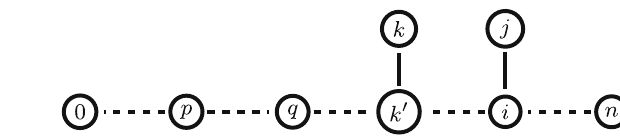
Figure 22: Minimum subgraph of C containing vertices {